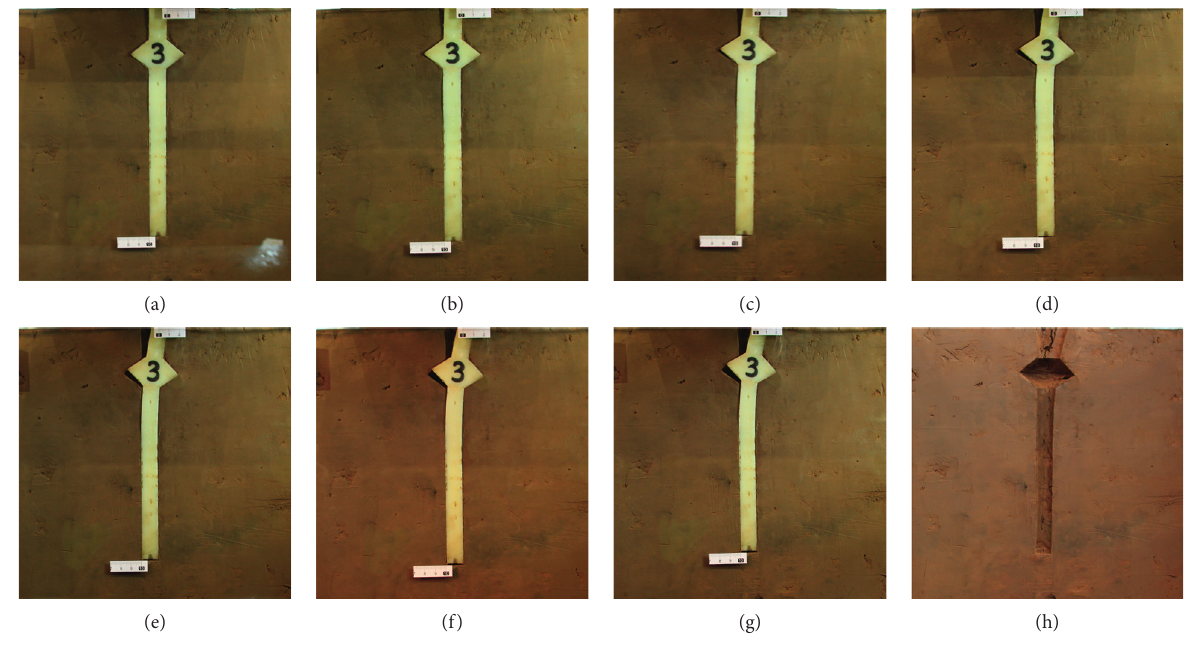
Figure 14: Pile and soil failure process for R3